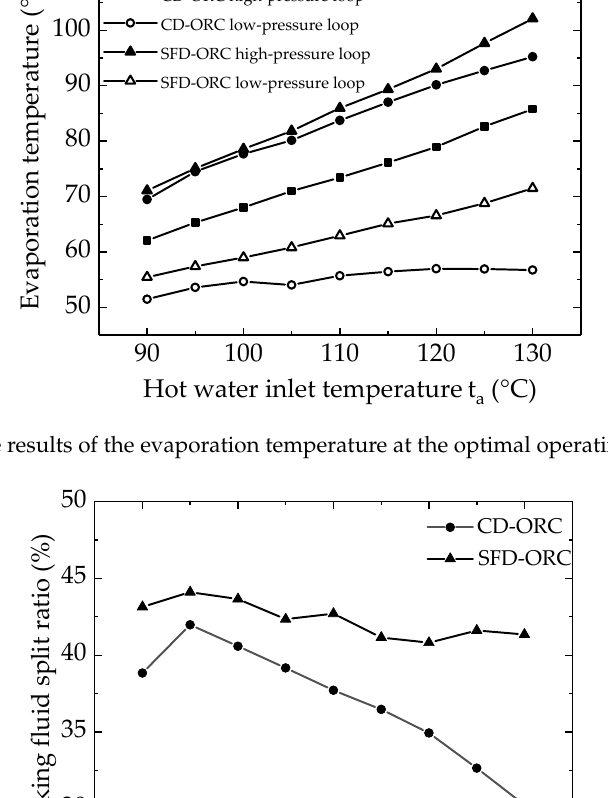
Figure 12. The results of the evaporation temperature at the optimal operating conditions.